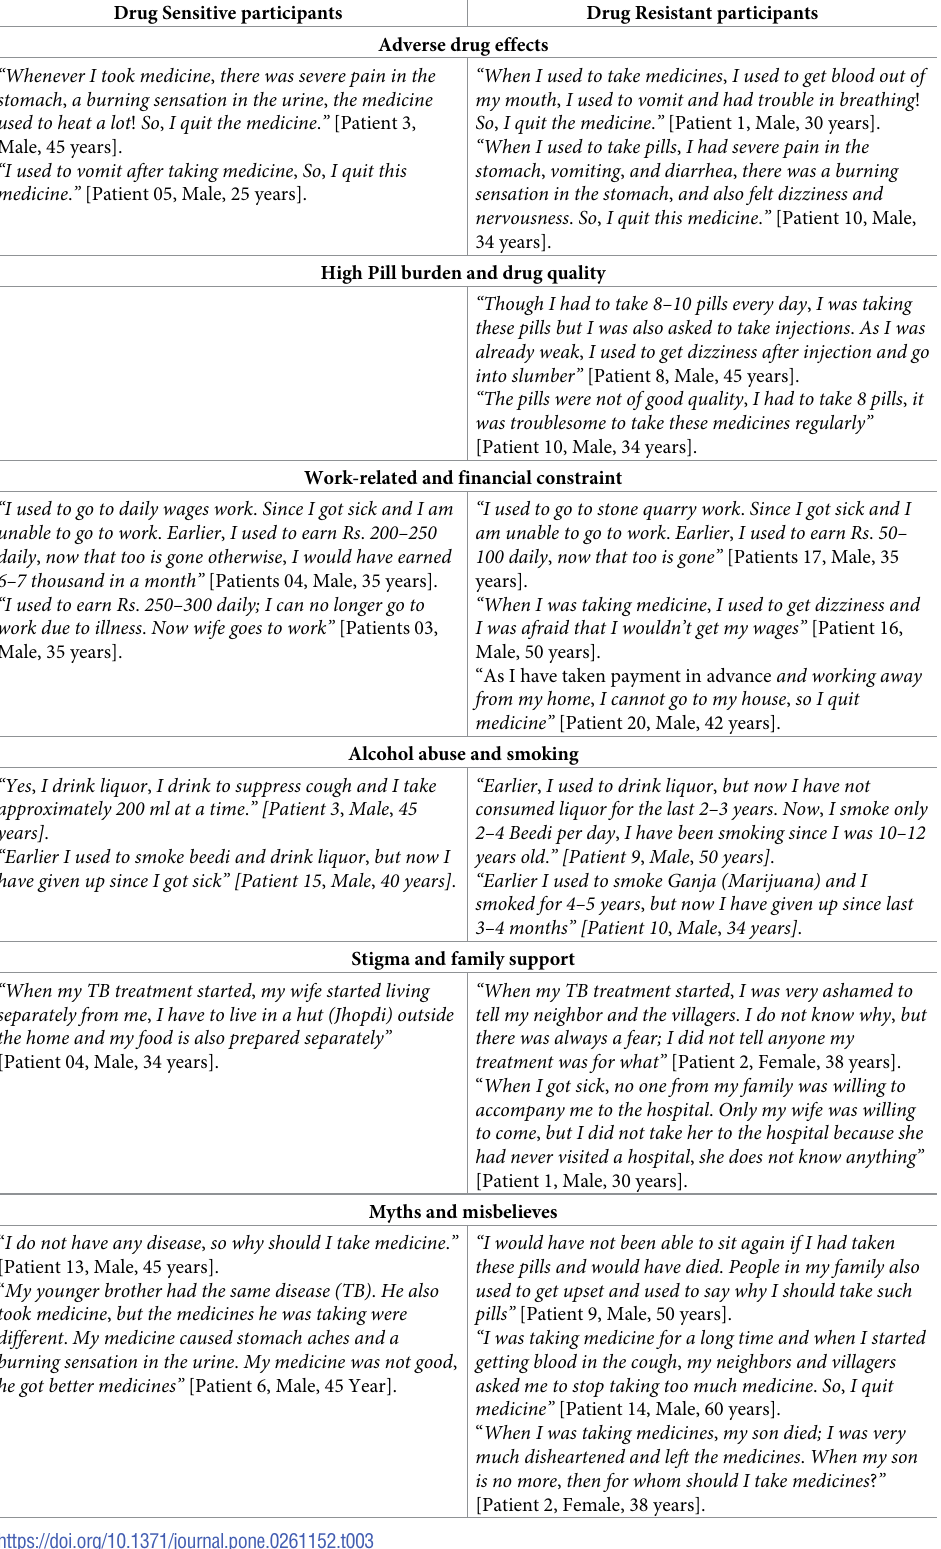
Table 3. Theme-wise important quotations of the drug-sensitive and drug-resistant study